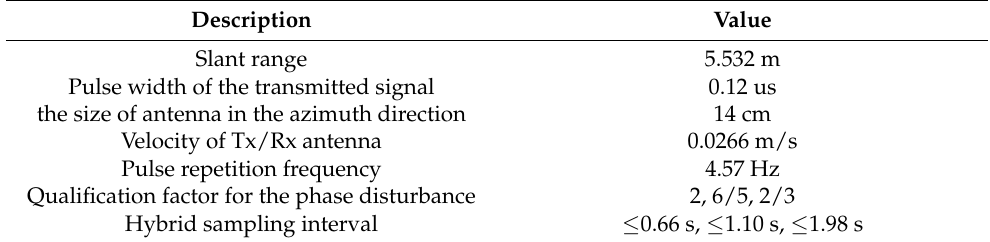
Table 5. Experimental parameters of the proposed non-uniform hybrid sampling technology.